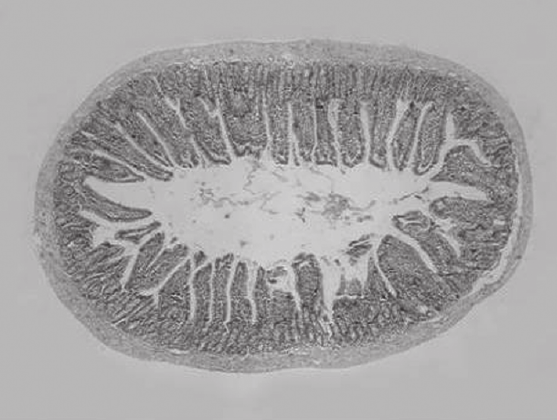
Figure 1 - Histological appearance of the control group (H&E x 40).